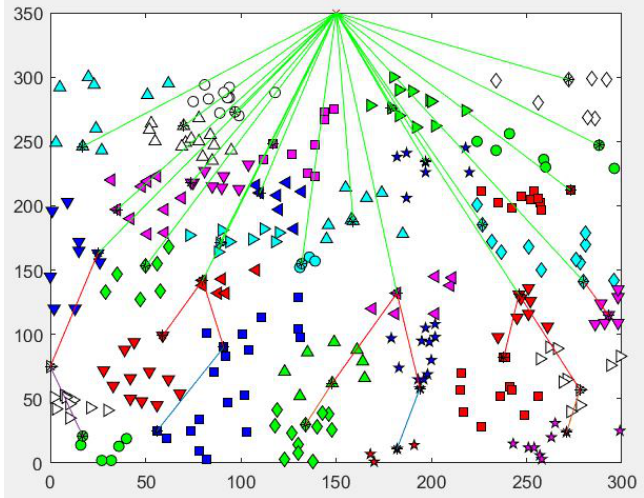
Figure 5. 500-Node Cluster sample.